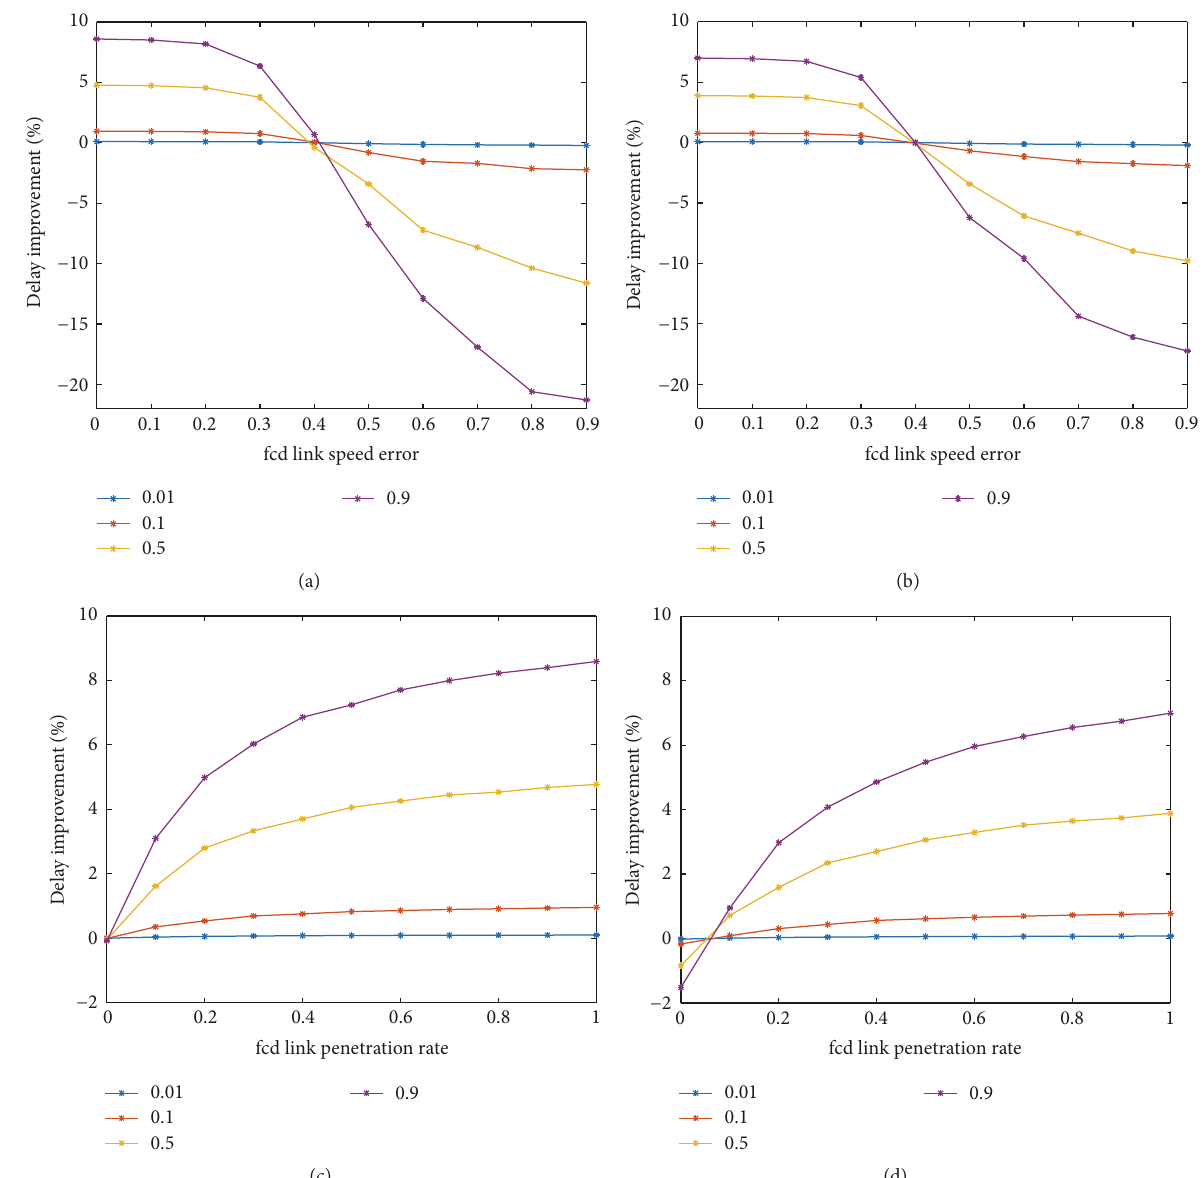
Figure 15: Delay improvement for 5 February 2016 (day with a lot of congestion) as percentage with regard to the normal delay: variation in link penetration with best route advice (a), variation in link penetration with top 3-route advice (b), variation in speed accuracy with best route advice (c), and variation in speed accuracy with top 3-route advice